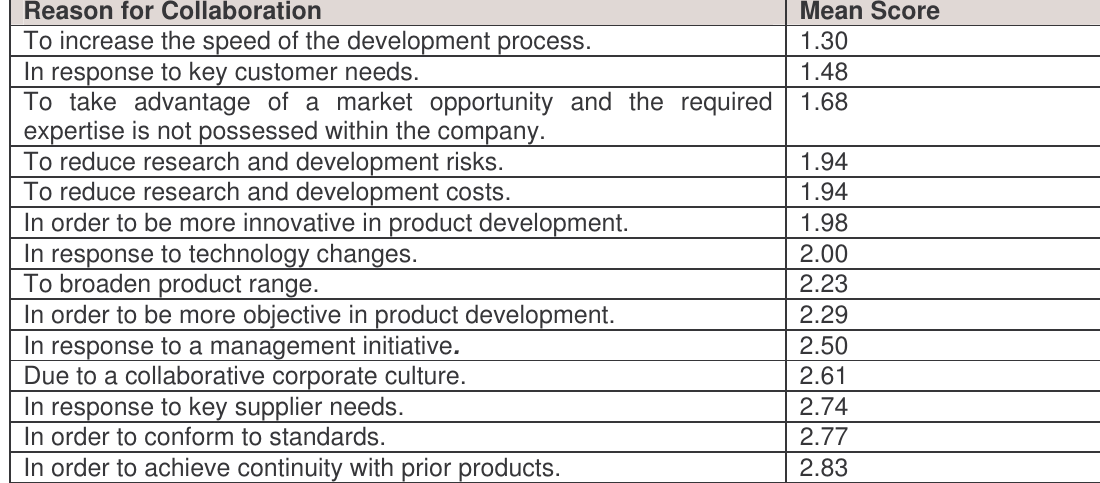
Table 1: Importance of reasons for collaborating in product development Reason for Collaboration Mean Score